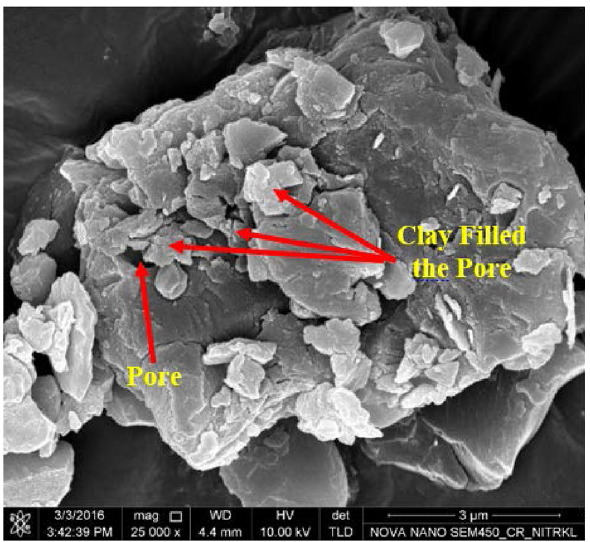
Fig. 10 FESEM image showing infilling of pores in coal sample ash content is attributed to the infilling and blockage of pores, cleats and fracture system with inherent and extrane- ous mineral matter such as clays and carbonates in coal. The infilling of the pores is also indicated in the FESEM image shown in Fig. 10. Fig. 11 Effect of fixed carbon (daf basis) on sorption capacity of coal. a CO 2 sorption and b CH 4 sorption